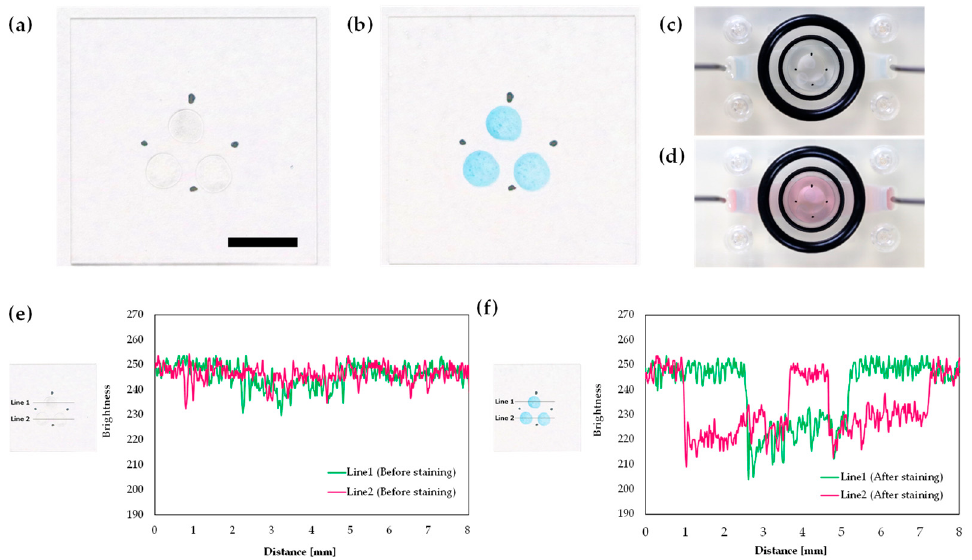
Figure 7. Protein spots on a cover glass: ( a ) before staining; ( b ) after staining by Coomassie blue dye. Topside view of the observation area of the 3D-printed cartridge with a protein spotted cover glass: ( c ) before Coomassie blue dye perfusion; ( d ) during perfusion. Brightness values of protein spots: ( e ) before staining; ( f ) after staining by Coomassie blue dye. Scale bar: 5 mm.